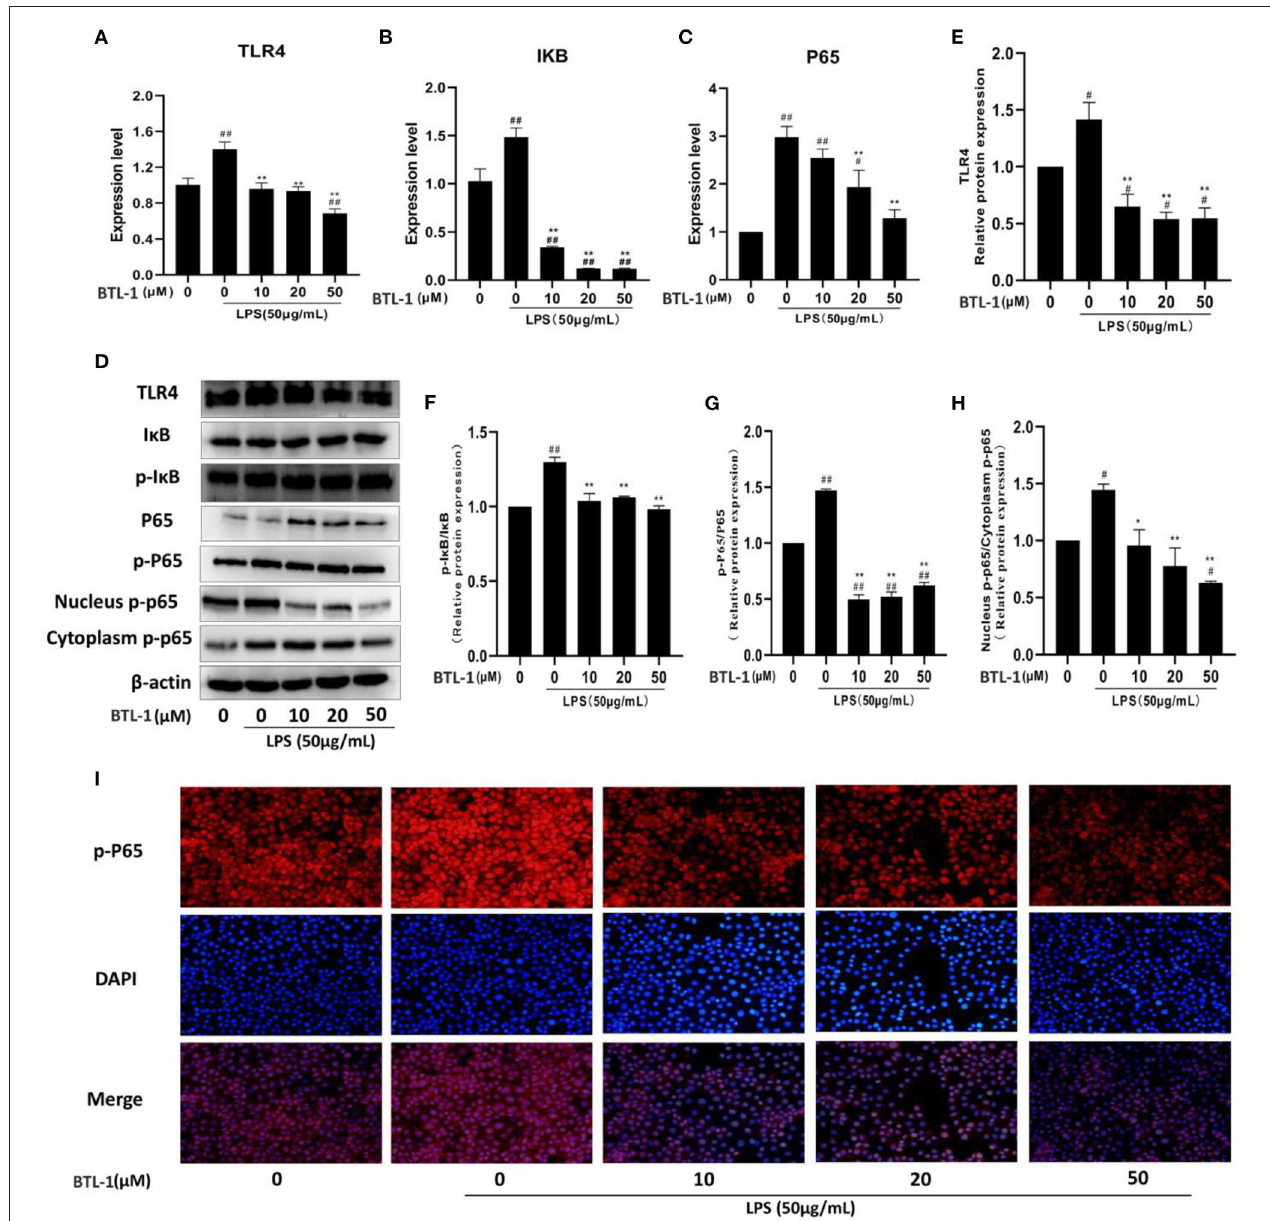
FIGURE 4 | Inhibitory effects of BTL-1 on TLR4/NF- κ B signaling pathway. BTL-1 inhibits TLR4/NF- κ B signaling pathway as determined by qPCR (A–C) and western blotting (D–G) . BTL-1 inhibits the translocation of phosphorylated P65 as determined by western blotting (D,H) and IF (I) . The data are representative of three independent experiments. The results were expressed as the means ± SEM. # P < 0.05, ## P < 0.01, compared to non-treated group, * P < 0.05, ** P < 0.01 compared to LPS